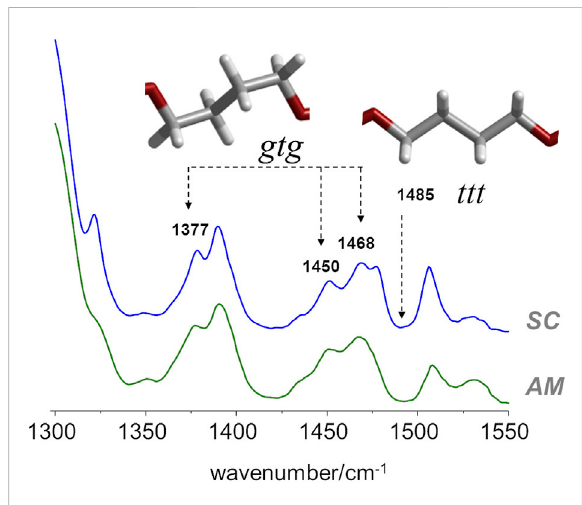
FIGURE 4 FTIR-ATR spectra of semicrystalline (top) and amorphous (bottom) samples of PBF, with identi fi cation of some bands sensitive to gauche − trans